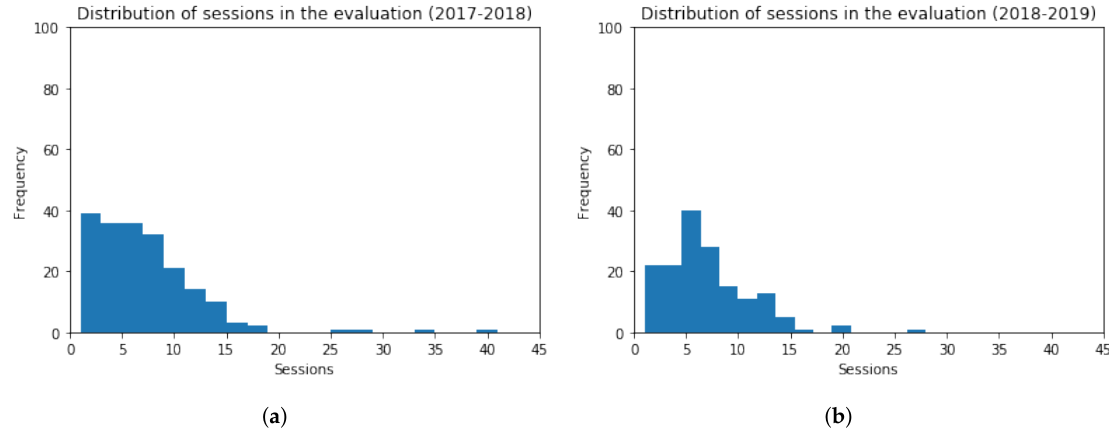
Figure 13. Histogram Graphs for the Number of Sessions using the Evaluation Resources. ( a ) 2017–2018 ( b )